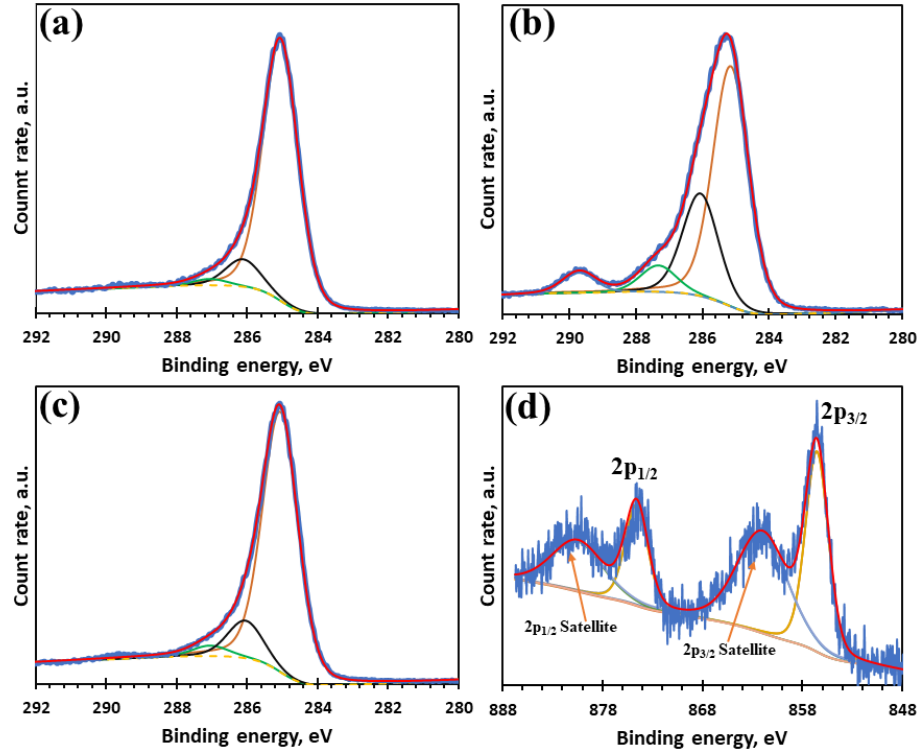
Figure 8: Deconvoluted C1s spectra of ( a ) pristine HCSs, ( b ) Ni@HCSs Ni(acet)2 , and ( c ) Ni@HCSs NiCl2 nanocatalysts, as well as ( d ) Ni 2p spectrum of Ni@HCSs Ni(acet)2 nanocatalysts.